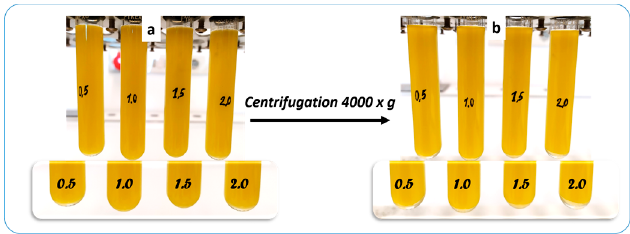
Figure 1. Effect of centrifugation on water-in-oil (W/O) emulsion stability. Emulsions aspect before ( a ) and after ( b ) centrifugation. The numbers on the test tubes refer to the percentage of water content.